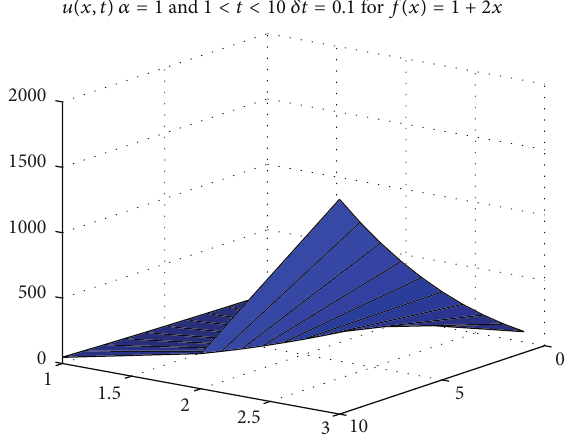
Figure 2: 𝑢(𝑥,𝑡) values for source function 𝑓(𝑥) at 𝛼 = 1 value. Figure 3: 𝑢(𝑥,𝑡) values for source function 𝑓(𝑡) at 𝛼 = 1/2 value.